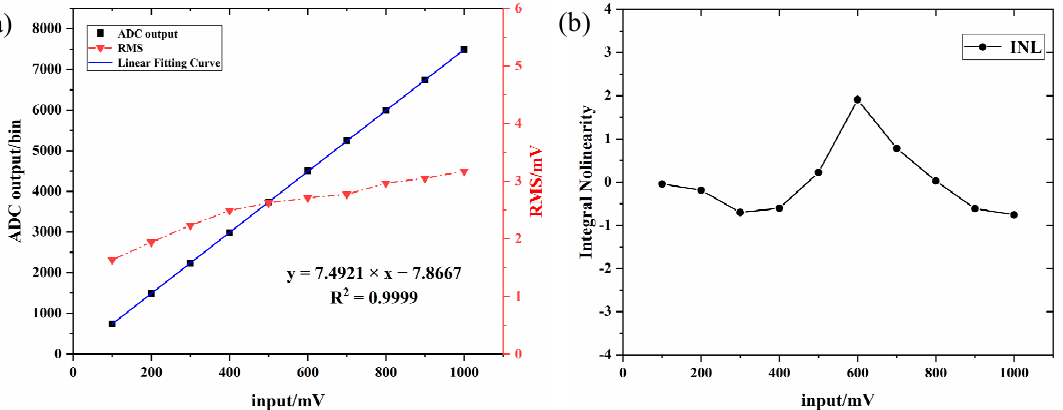
Figure 13. ( a ) Linearity fit and RMS noise of the RCM. ( b ) Integral Nonlinearity corresponds to different input values.